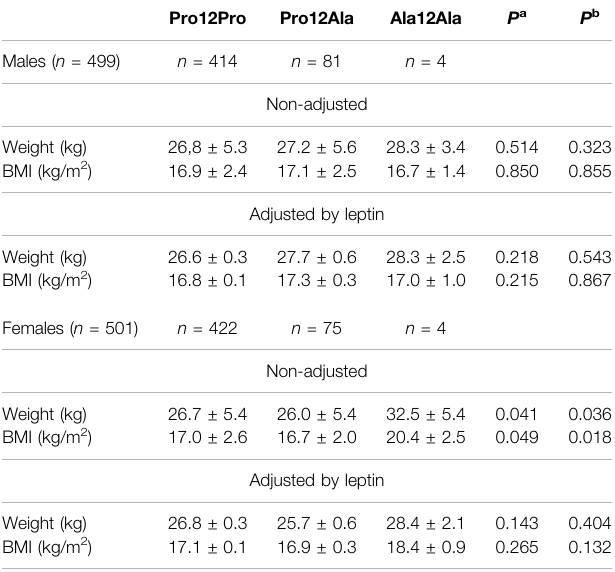
TABLE 3 | Anthropometric parameters (mean ± SD) according to the PPAR γ 2 Pro12Ala genotype by sex. Pro12Pro